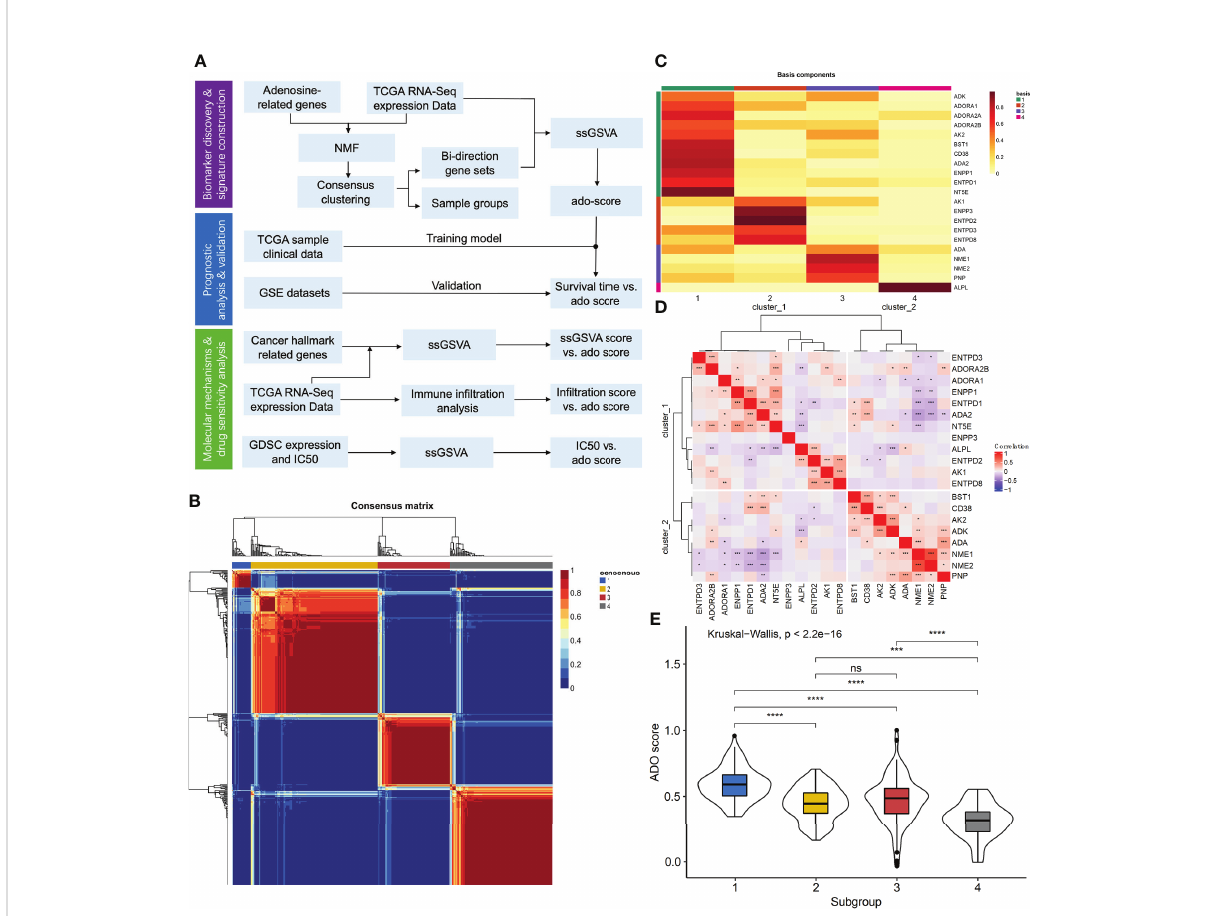
FIGURE 1 The construction of adenosine signature. (A) The fl owchart of the study; (B) The consensus map of NMF clustering; (C) The metagenes obtained from NMF cluster; (D) The correlation matrix of adenosine metabolism related genes expression; (E) The boxplots of ADO score for different samples clusters. (ns: P > 0.05, *P < 0.05, **P < 0.01, ***P < 0.001, ****P <